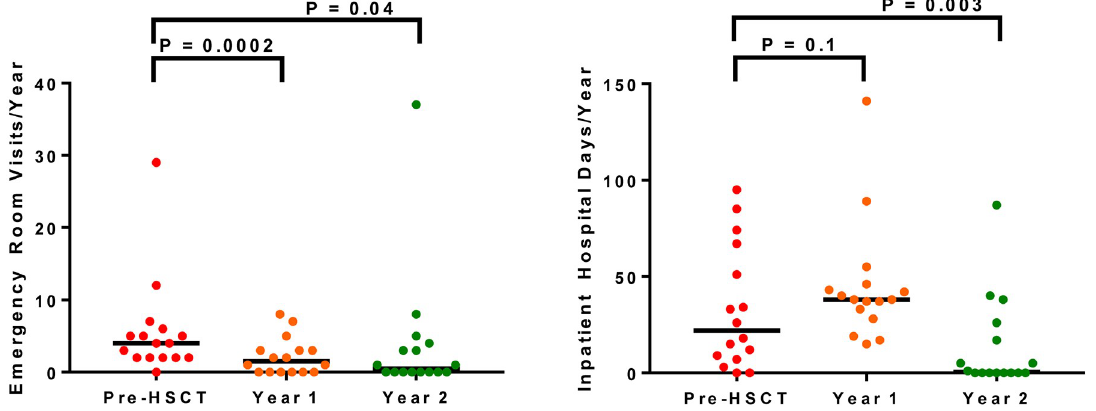
Fig 2. Health care utilization. (A) Emergency visits improved from pre-HSCT (4 visits, IQR 2–6 visits) to 1 year (2 visits, IQR 0–3 visits) and 2 years post-HSCT (1 visit, IQR 0–4 visits). (B) The number of inpatients days increased from pre-HSCT (22 days, IQR